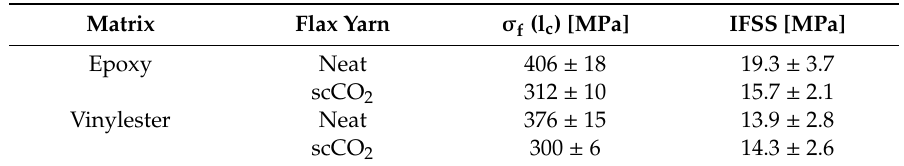
Table 5. Strength values at critical fragment length and interfacial shear strength values (IFSS) for the di ff erent flax / epoxy and flax / vinylester